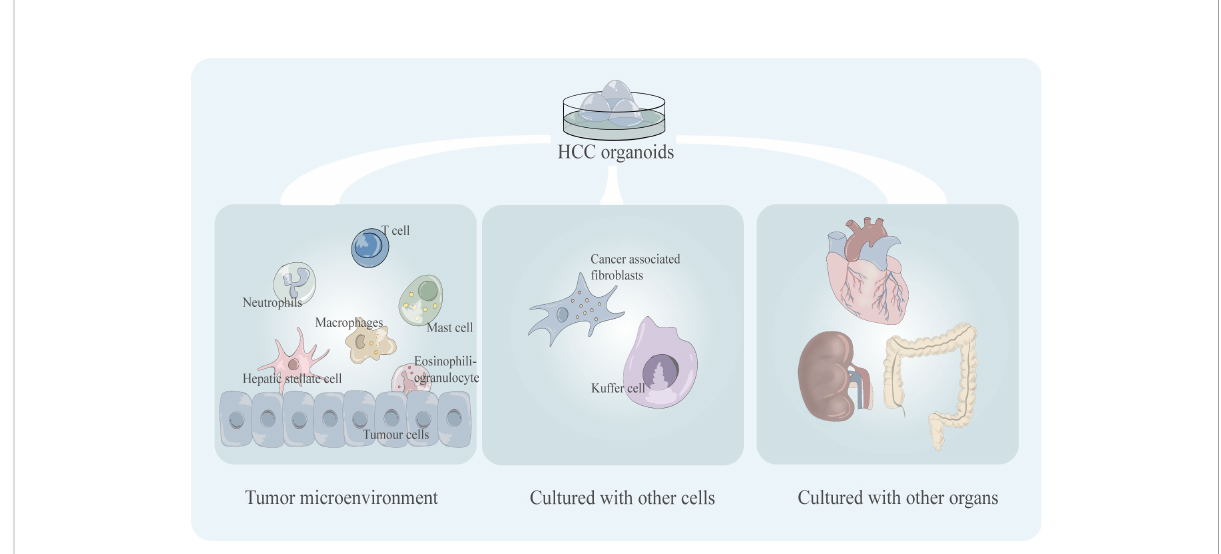
FIGURE 5 Key shortcomings of existing HCC organoid models including the incomplete tumor microenvironment (tumor immune microenvironment) and the lack of co-culture mode, including co-culture with multiple cells and co-culture with multiple organs.